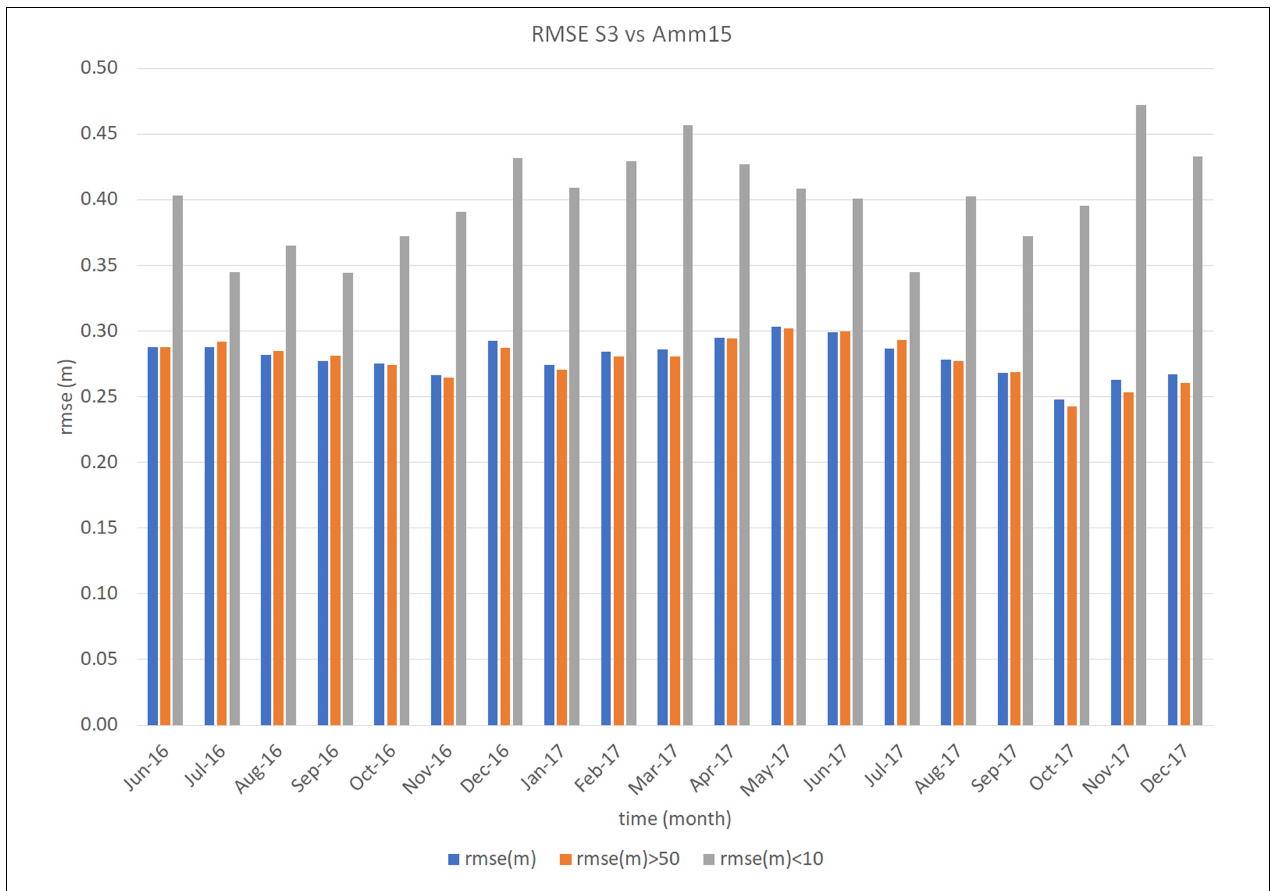
FIGURE 8 | Statistics for the Amm15-S3 comparison. Mean monthly results from June 2016 to December 2017 (for Amm15-S3).